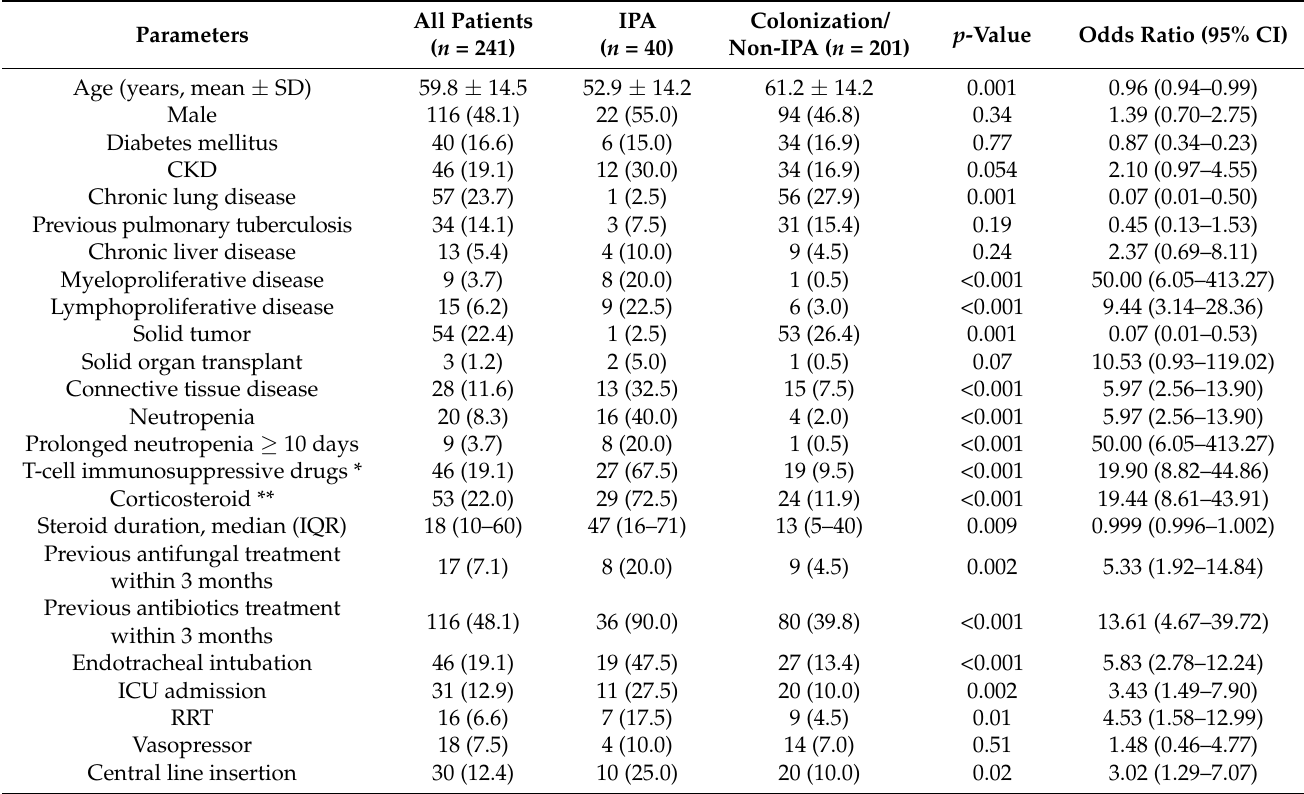
Table 2. Patient demographic and clinical characteristics.